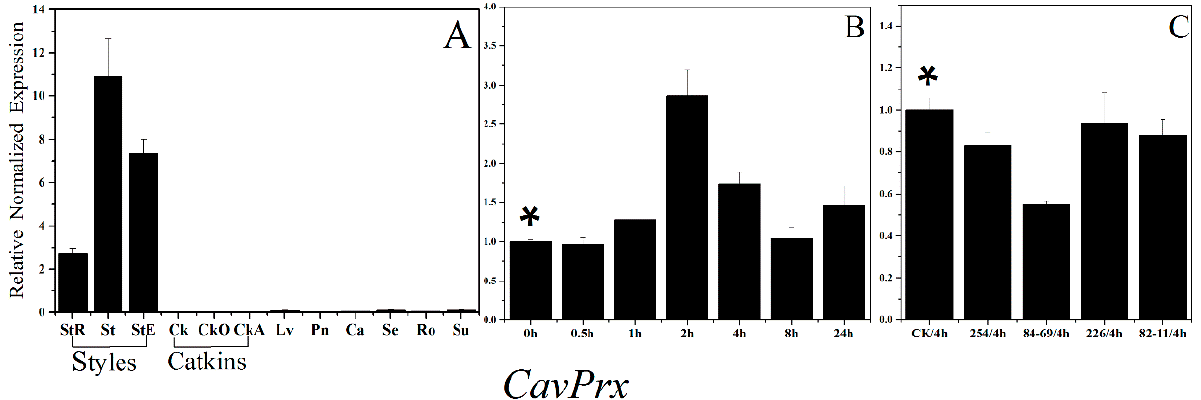
Figure 6. Expression analysis of the target gene, CavPrx , using ChaActin and ChaEF1- α as reference genes. * Control samples. The expression level of CavPrx ( A ) in different tissues, ( B ) at different times after self-incompatible pollination, ( C ) at 4 h after different affinity pollination. StR, styles at red-dot stage; St, blooming styles; StE, styles at the end-flower stage; Ck, catkins before elongation; CkO, catkins during elongation; CkA, catkins after elongation; Lv, young leaves; Pn, pollen; Ca, cambium of annual branch; Se, green stem; Ro, root tip; Su, sucker; 0 h, self-pollination 0 h; 0.5 h, self-pollination 0.5 h; 1 h, self-pollination 1 h; 2 h, self-pollination 2 h; 4 h, self-pollination 4 h; 8 h, self-pollination 8 h; 24 h, self-pollination 24 h; CK/4 h, non-pollination 4 h; 254/4 h: incompatible pollination 4 h with 84–254; 84–69/4 h; incompatible pollination 4 h with 84–69; 226/4 h, compatible pollination 4 h with 84–226; 82–11/4 h, compatible pollination 4 h with